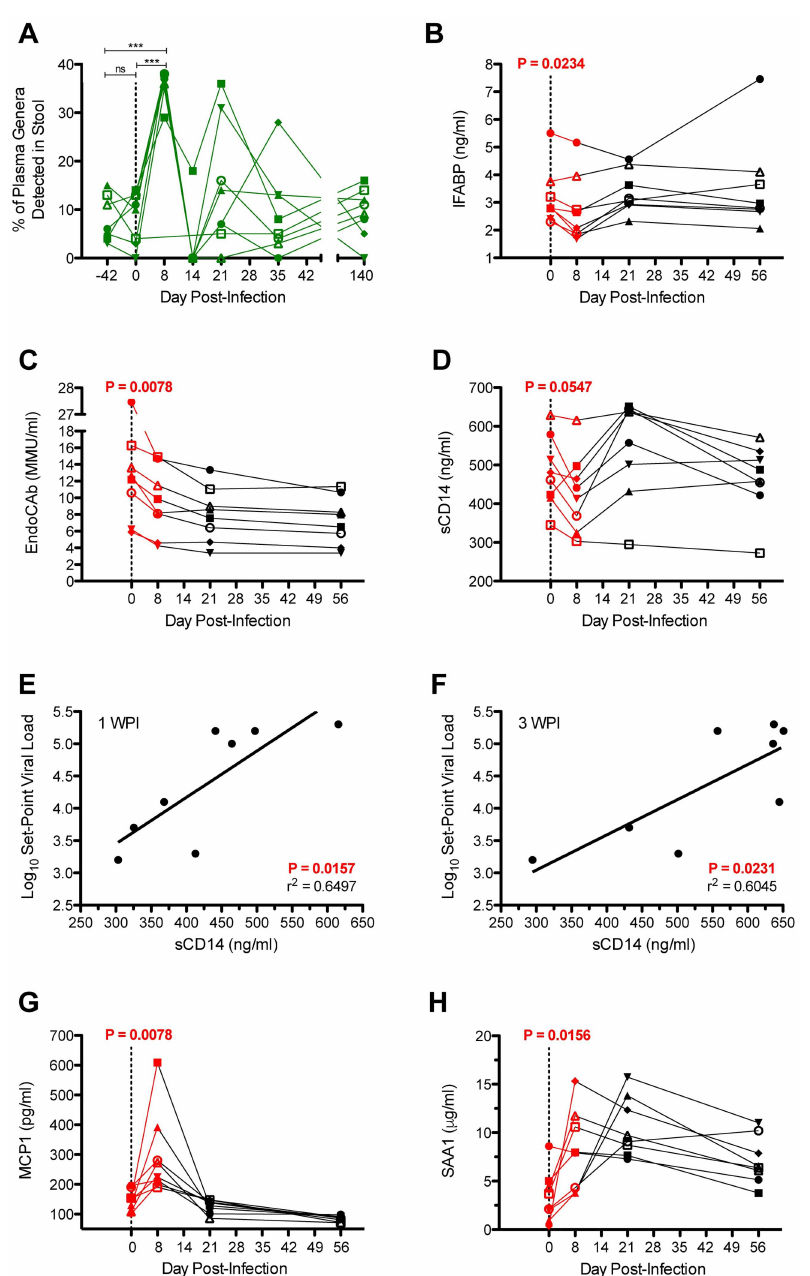
Fig 3. Plasma markers of intestinal breach and host response to microbial translocation. ( A ) Longitudinal proportion(%) of plasma generadetected in contemporaneousstool. Each line correspondsto a singleanimal. Bonferroni-corrected one-wayANOVA was used to calculatestatistical significance. ( B ) Longitudinal plasma levels of IFABP, a marker of enterocyte loss and generalizeddamageto the intestinal epithelium. The host responseto microbialtranslocation was measuredusing plasma levels of ( C ) EndoCAb, and ( D ) sCD14. By linear regression analysis, plasma levels of sCD14 at ( E ) 8 DPI, and ( F ) 21 DPI correlated positivelywith chronic-phase set-point viral loads. Acute inflammation was measuredusing plasma levels of ( G ) MCP-1, and ( H ) SAA1. For B, C, D, G, and H, differences between0–8 DPI were evaluatedfor statistical significanceby two-tailedWilcoxon signed rank